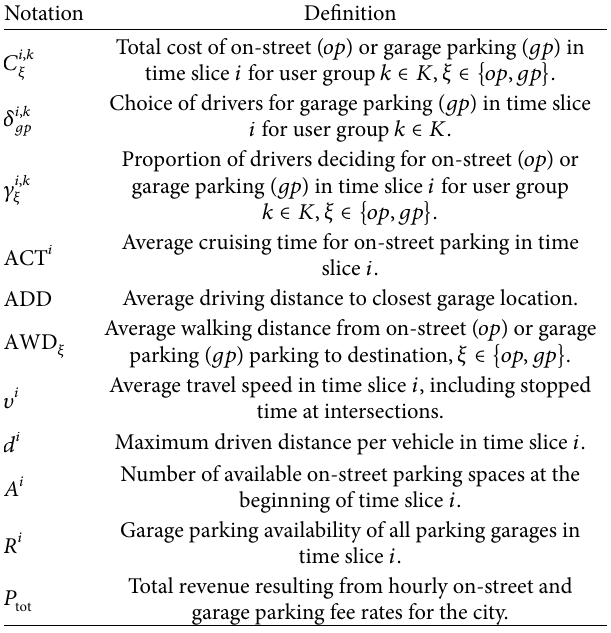
Table 3: Intermediate model